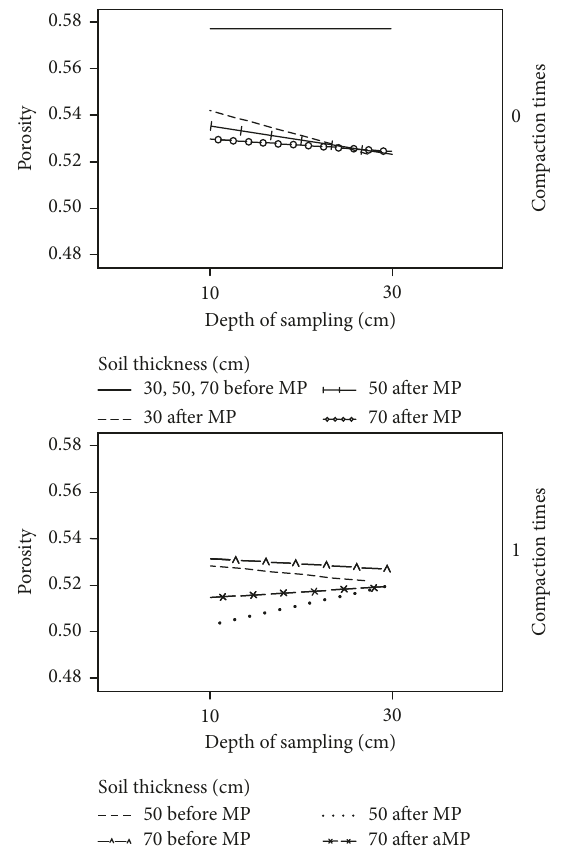
Figure 11: Change of the porosity of a different topsoil thickness to various times of compaction before and after the maintenance period. MP: maintenance